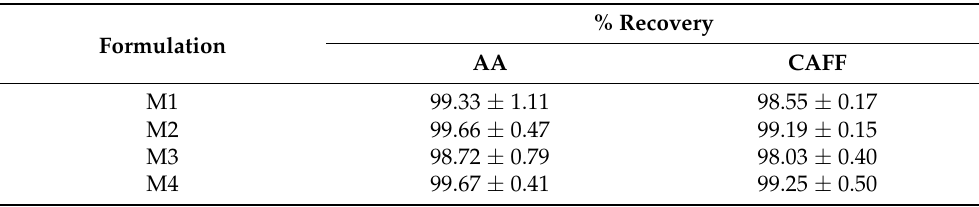
Table 6. The percentage recovery of AA and CAFF from DMN a .